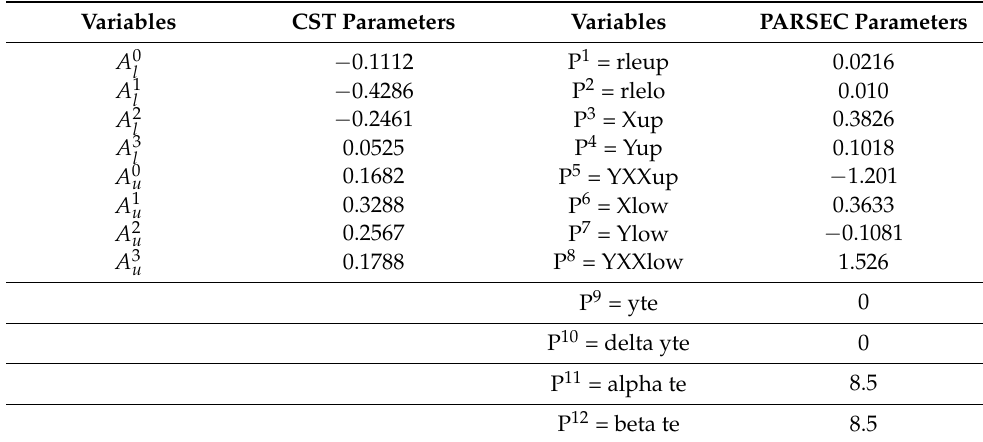
Table 5. The design parameters for the NREL S809 airfoil.